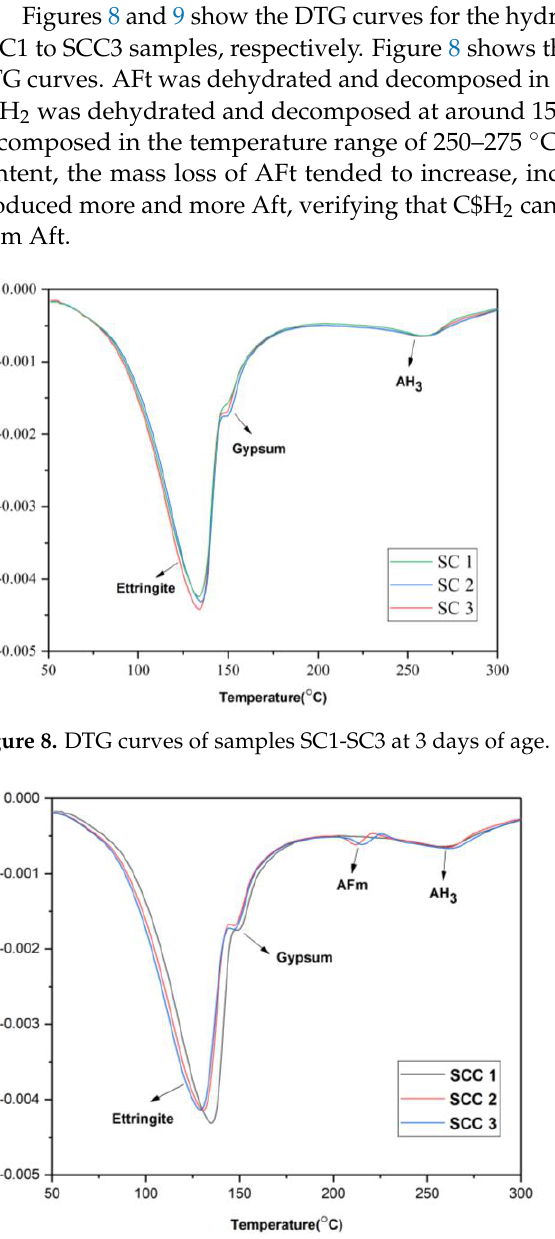
8 of 13 Figure 7. Percentage mass content of samples SC1-SC3 and SCC1-SCC3 at 3 days of age.